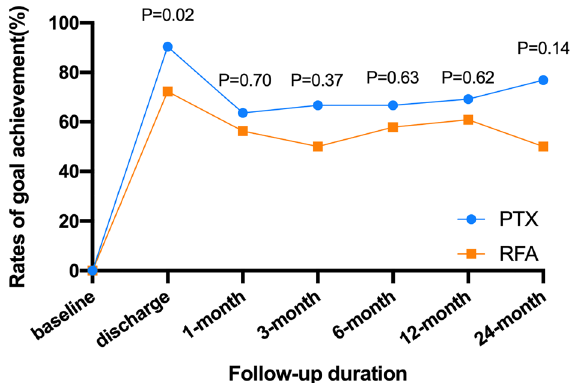
Figure 1. Comparisons of the rates of goal achievement in serum iPTH between the PTX group and the RFA group during the follow-up period.